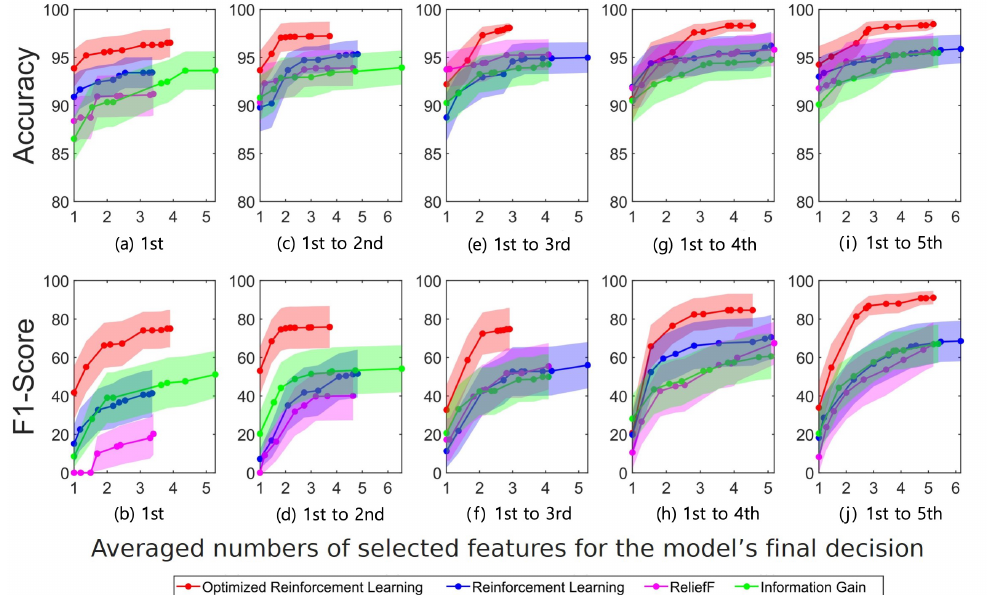
Figure 5. Support vector machine (SVM) results using the costly features. The accuracy and F1-score values across all subjects are illustrated with their variances in shades (corresponding to the training days). Each training dataset includes the electrocardiogram (ECG) signals recorded on the ( a , b ) 1st day,